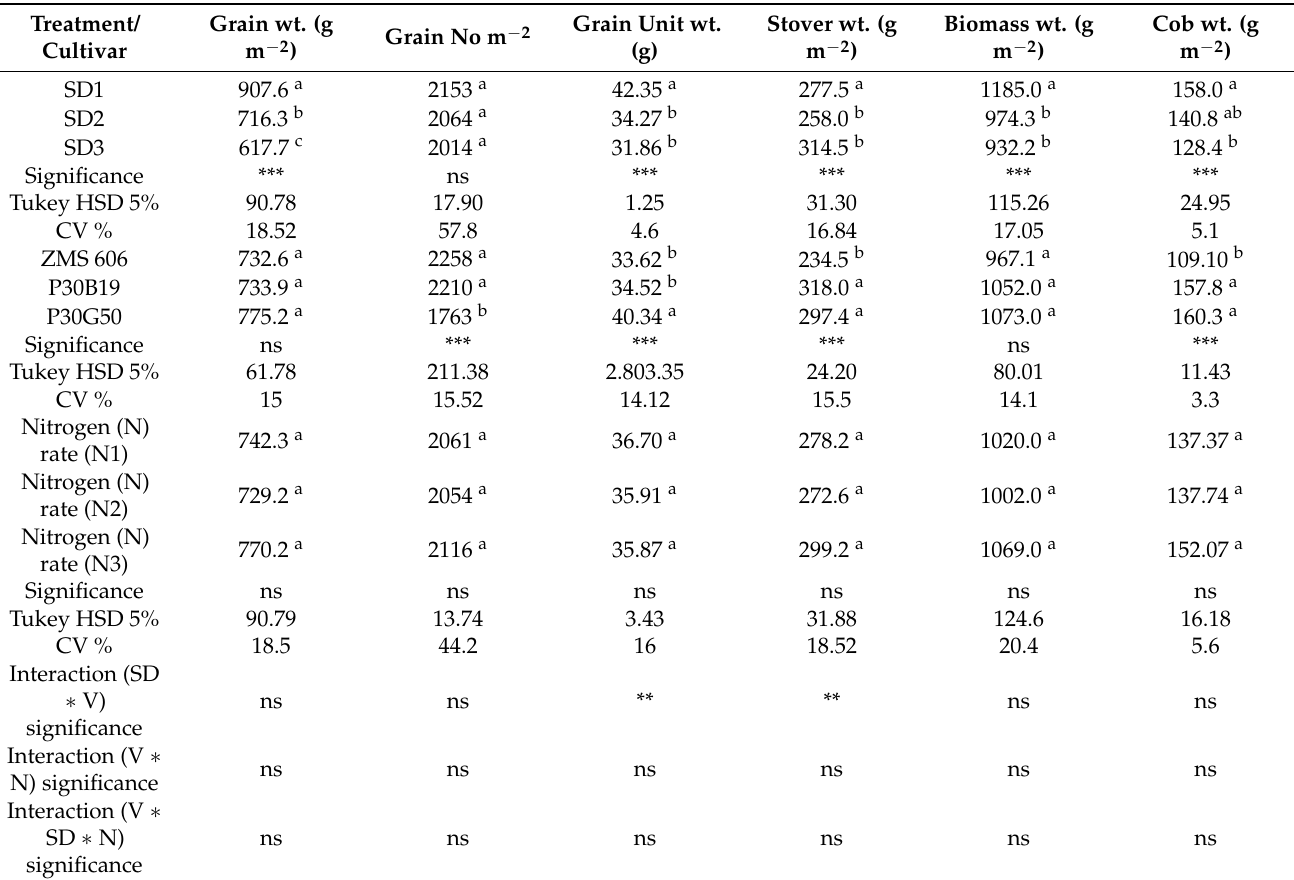
Table 3. Treatment effect of the sowing date, cultivar and N on the grain wt., grain number m − 2 , grain wt., stover wt., aboveground biomass wt. and cob wt. under rainfed